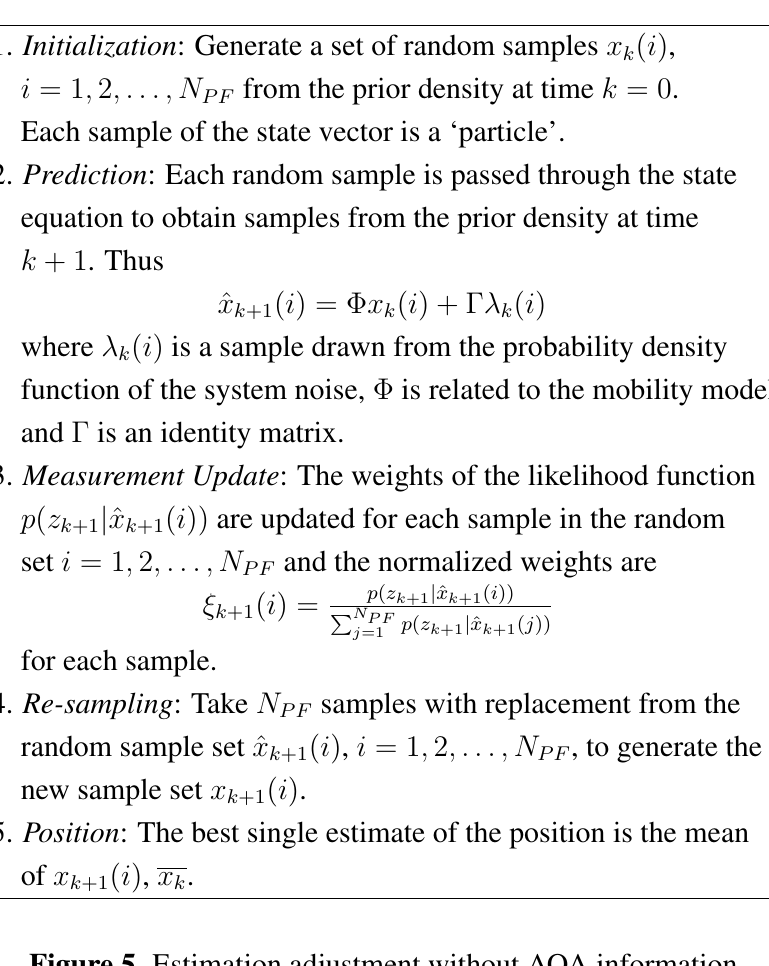
Figure 5. Estimation adjustment without AOA